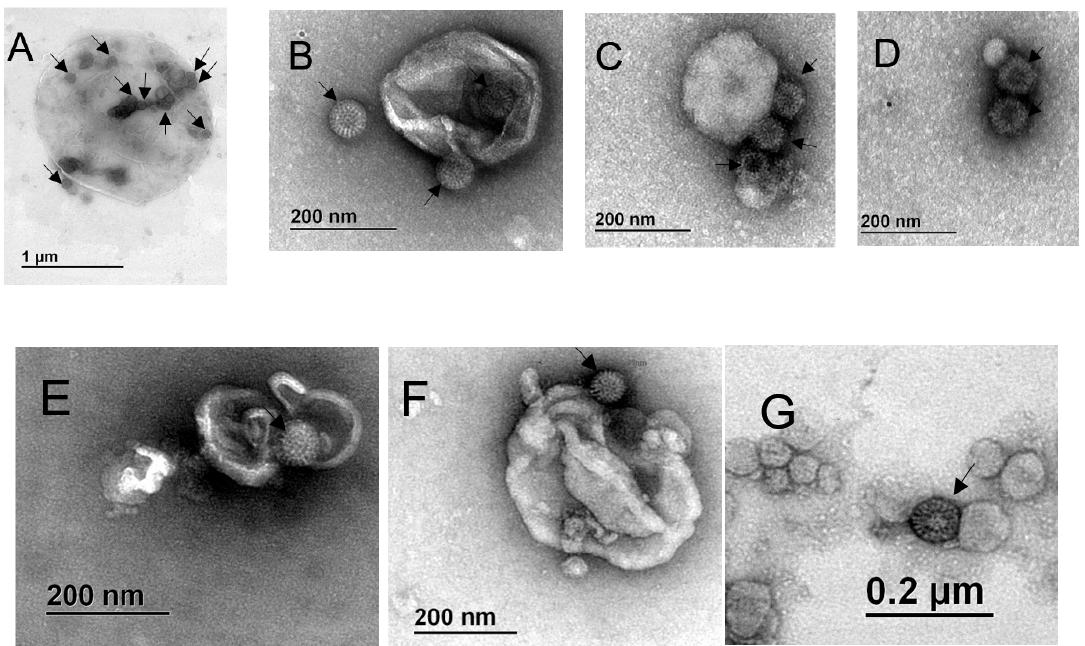
Figure 5. Rotavirus particles associate from the outside and inside of extracellular vesicles. Confluently grown MA104 and Caco-2 cells were infected with RRV strain, for 10 or 18 h, respectively, the time after which the cell culture supernatant was collected. Fraction P2 was obtained by centrifugation at 2000 × g , P3 at 9600 × g and PEG fraction by precipitation with PEG6000, and vesicles were then isolated using MagCapture TM Exosome Isolation Kit PS. One drop of sample was fixed onto carbon vaporized coper grids and negatively stained with uranyl acetate. Samples were observed in EFTEM ZEISS Libra 120 electron microscope. ( A ) MA104 cells P2; ( B ) MA104 cells P3; ( C , D ) MA104 cells PEG; ( E , F ) Caco-2 cells P3; ( G ) Caco-2 cells PEG. Particles resembling rotavirus structure are pointed by arrows. Size bars are shown.